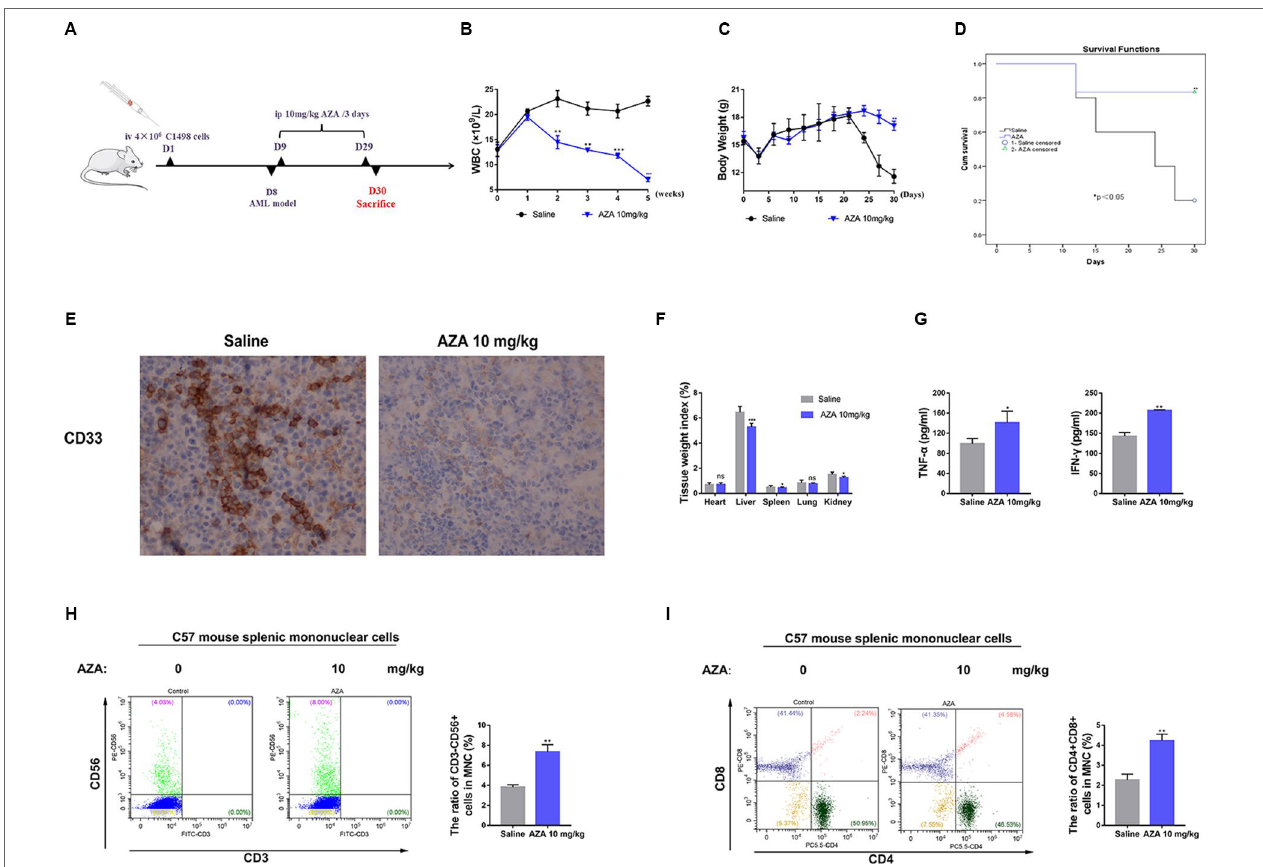
FIgUrE 7 | Azelaic acid (AZA) inhibits the tumorigenicity of acute myeloid leukemia (AML) in vivo . (A) The construction of leukemia-bearing mice model and the therapeutic pattern. (B) Body weight change. (c) White blood cell counting. (D) : Survival analysis. (E) Leukemia cells showed spleen infiltration by the ICH method. (F) Tissue weight index. (g) The level of TNF-α and IFN-γ in plasma. (h) Mouse MNCs were stained with CD3 and CD56 for flow cytometric analysis. Right, the percentage of positive staining cells. (I) Mouse MNCs were stained with CD3, CD4, and CD8 for flow cytometric analysis. Right, the percentage of positive staining cells. MNCs: the splenic mononuclear